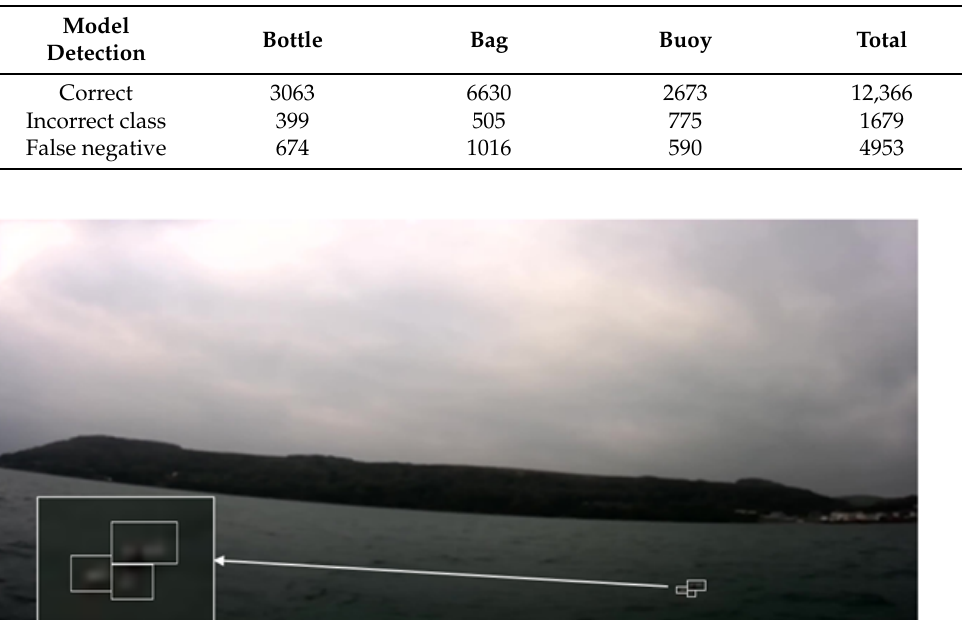
Table 3. Quantity of plastic correctly identified, misidentified as the incorrect class or not identified by the model. The table shows these quantities for the bottles, bags, buoys and total plastics from the test data set. The number of plastics refers to how many times the model has detected a plastic item. Many of these detections will be from the same plastic item counted multiple times.